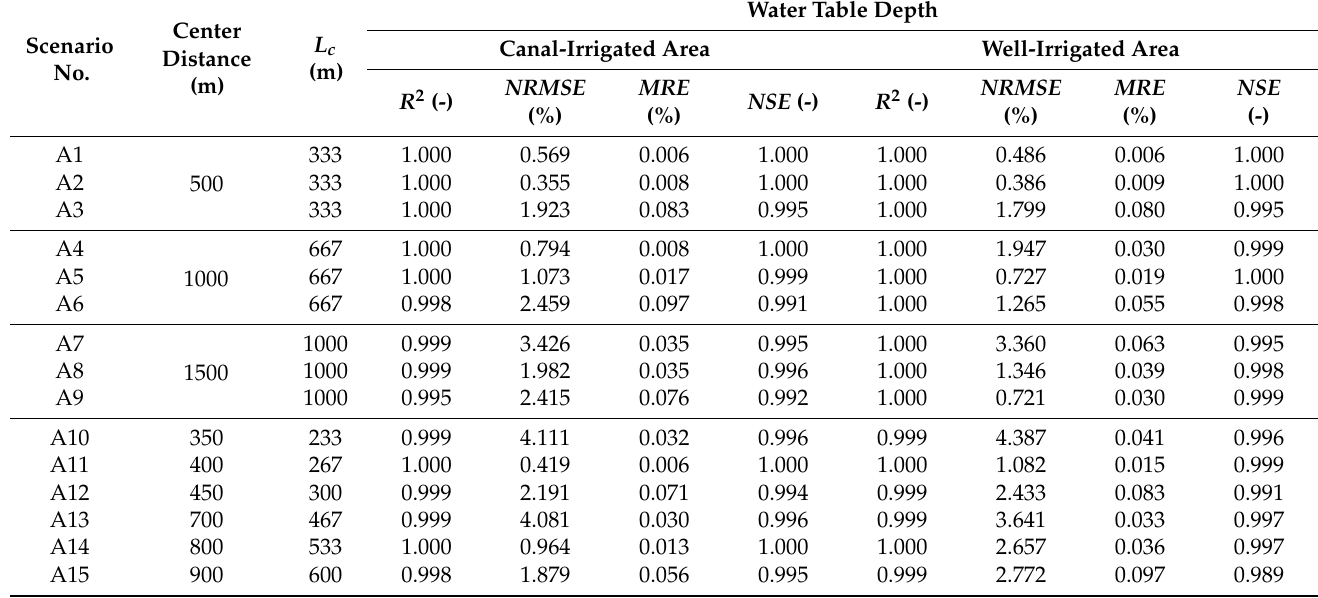
Table 3. Model performance under 15 scenarios while L c is two-thirds of center